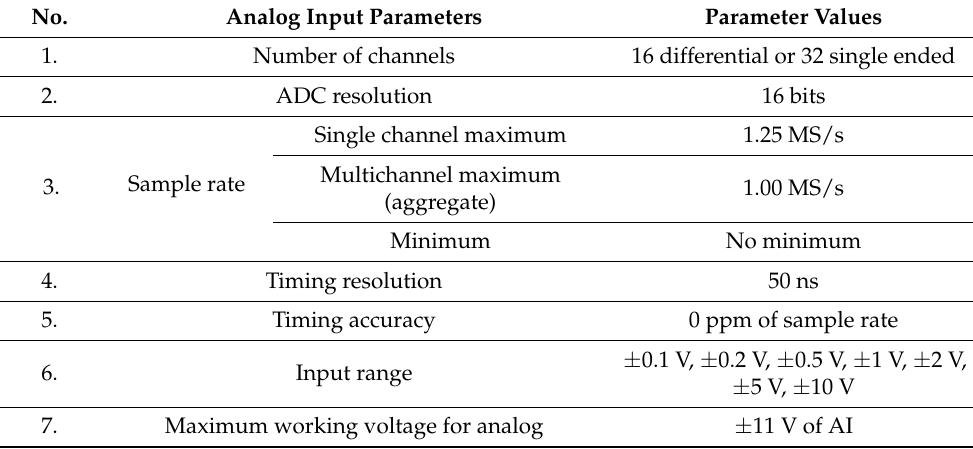
Table 3. Analog input parameters of the NI USB 6259 DAQ card.